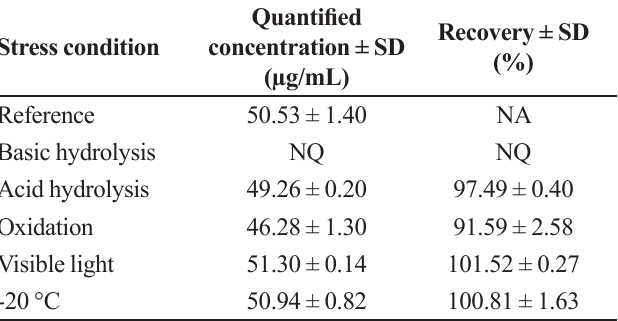
TABLE V - Results of quantification of FA after forced degradation test for 24 h